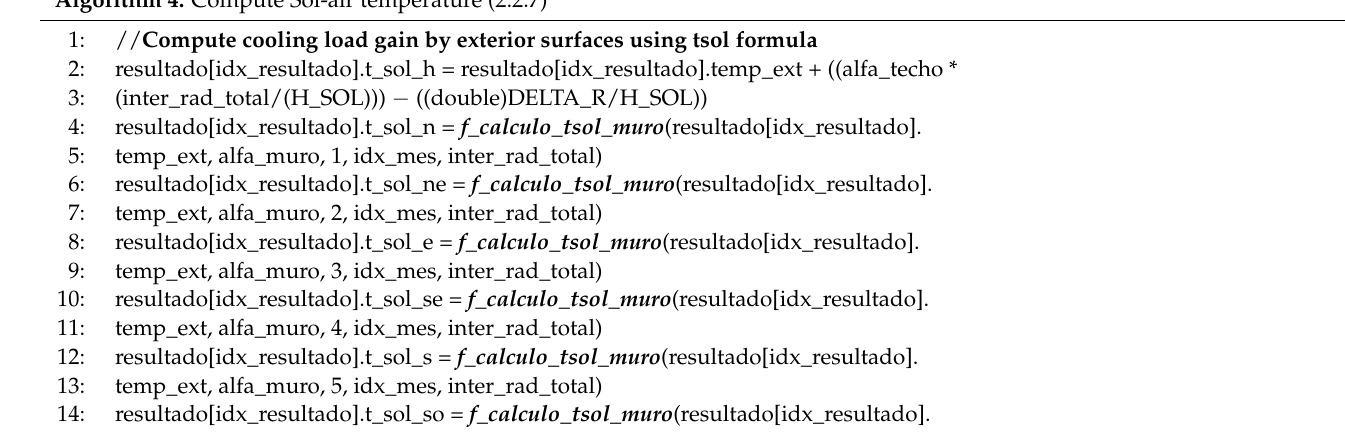
Algorithm 4. Compute Sol-air temperature